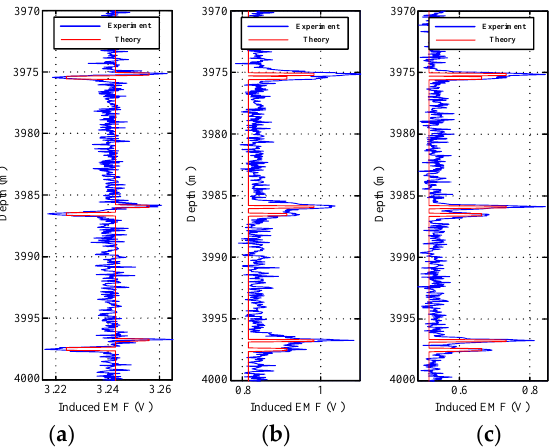
Figure 13. Induced EMF of the two sensors at different times ranging from 3970 to 4000 m: ( a ) main sensor at 20 ms; ( b ) main sensor at 50 ms; and ( c ) auxiliary sensor at 30 ms.